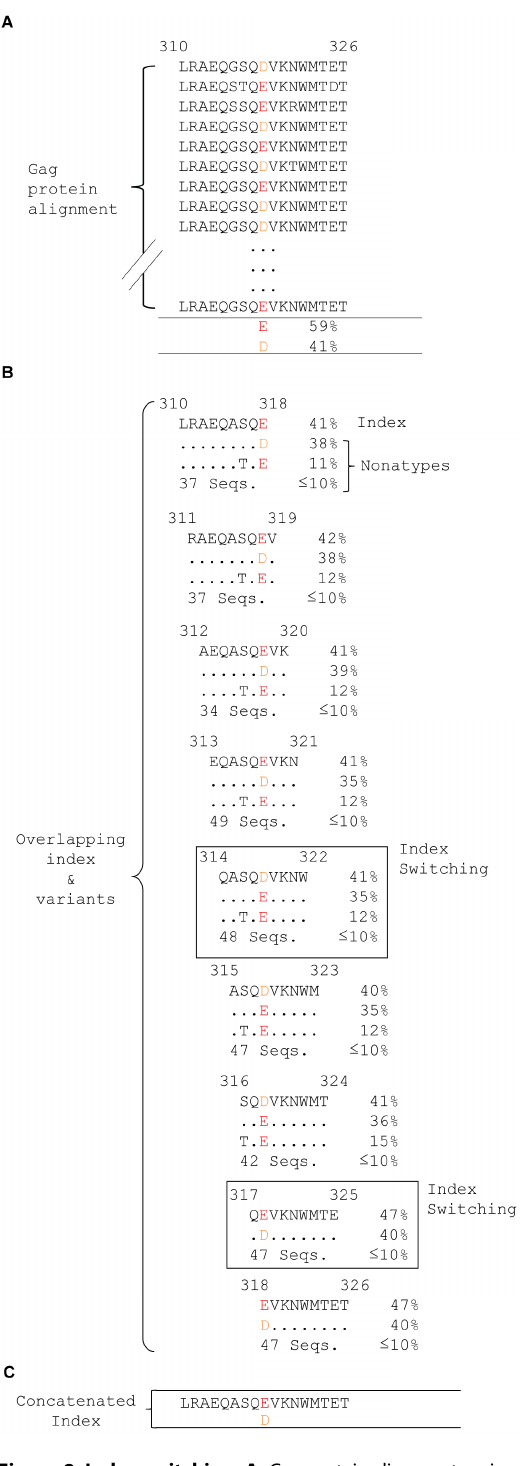
Figure 8. Index switching. A. Gag protein alignment region of amino acid (aa) positions 310 to 326 is shown for the first and last five sequences of the aligned viruses. The aa position 318 (coloured) is involved in index switching and includes two aa, the prevalent E observed in 59% of the sequences, with its variant D in 41%. B. The nine aligned overlapping nonamer positions (310–318, 311–319, etc .) represent the sliding windows of the alignment region in A. Each nonamer position is shown with the index sequence, two of the variant nonatype sequences and the total number of remaining variant nonatypes of incidence equal or below 10%. The first nonamer